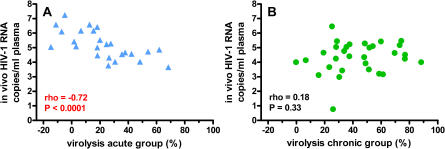
Correlation Analysis of Complement Virolysis and In Vivo Viremia LevelsIn vitro-determined autologous virolysis activity was correlated with in vivo HIV-1 RNA copies measured per milliliter of plasma in the acutely infected group (A) and the chronically infected group (B). Correlations were evaluated using Spearman's rank correlation. Our data demonstrate that increased antibody-mediated complement lysis coincides with lower viral loads in the acute phase. No evidence was found for a similar correlation in the chronically infected group.